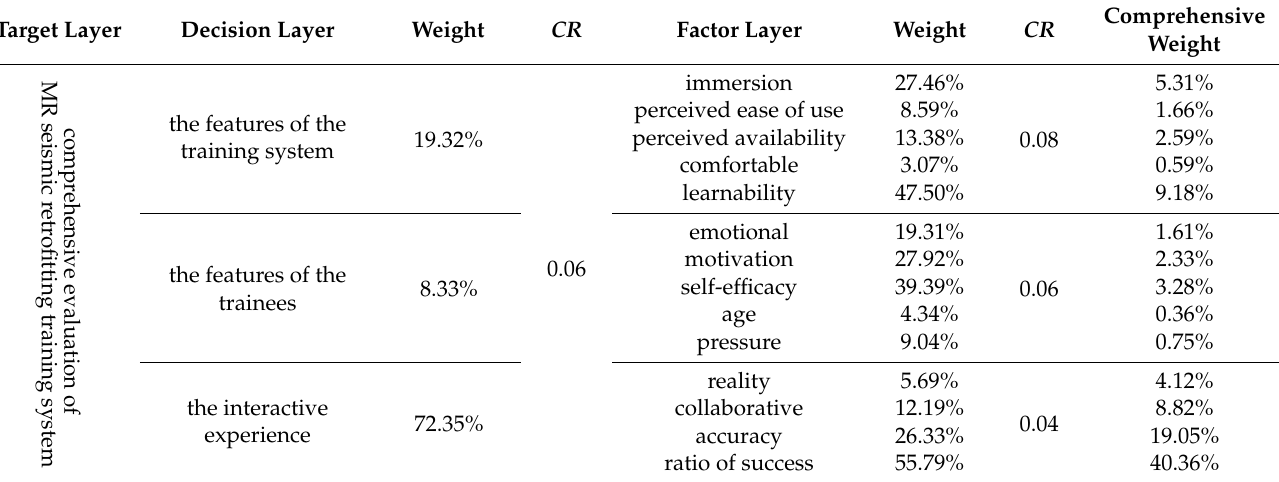
Table 5. Detailed data on the weight value and CR value of each evaluation